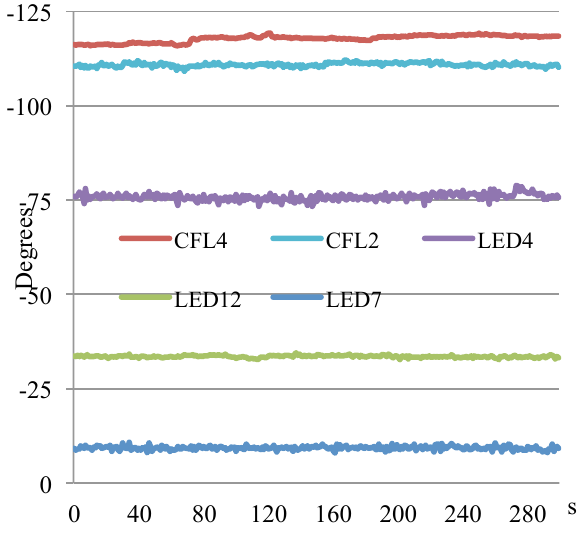
Figure 5: Stability of the phase angle of the third–order harmonic current for several lamps used in this work.